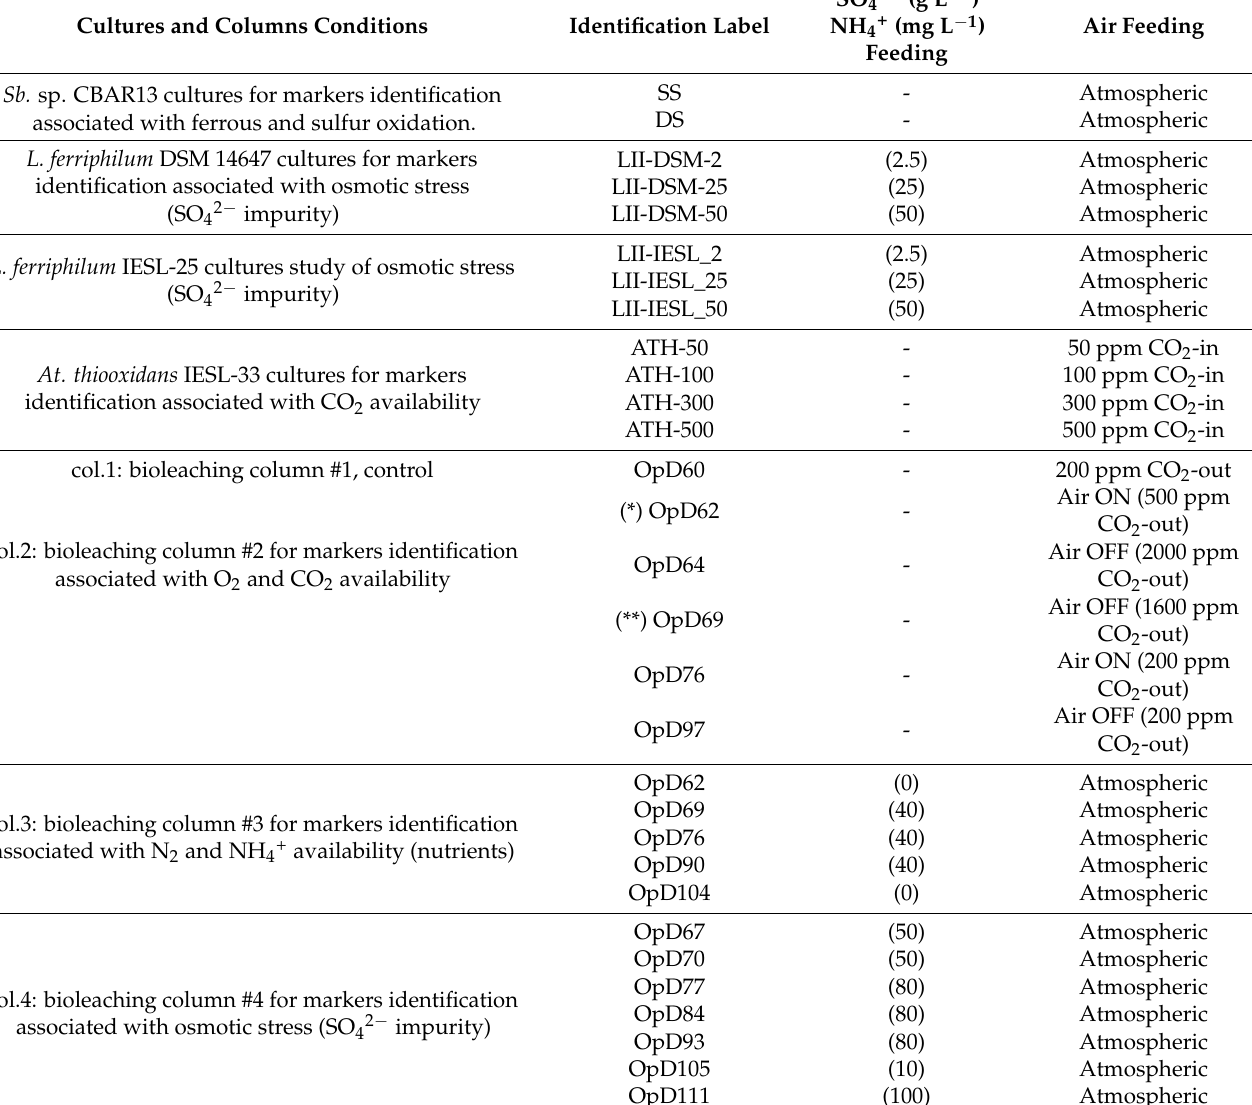
Table 1. Samples collected from L. ferriphilum DSM 14647, L. ferriphilum IESL-25, At. thiooxidans IESL-33, and Sulfobacillus sp. CBAR13 cultures and from the bioleaching columns (col.1, col.2, col.3, col.4) at several operational times and specific running conditions (CO 2 , SO 42 − , and NH 4+ availability). (*) Air displacement with N 2 in col.2. (**) Restoration of regular aeration in col.2. OpD, operation day; CO 2 -out, output CO 2 concentration; SS, single-strength medium (with Fe 2+ as an energy source), DS, double-strength medium (with K 2 S 4 O 6 as energy source); Sb. sp., Sulfobacillus